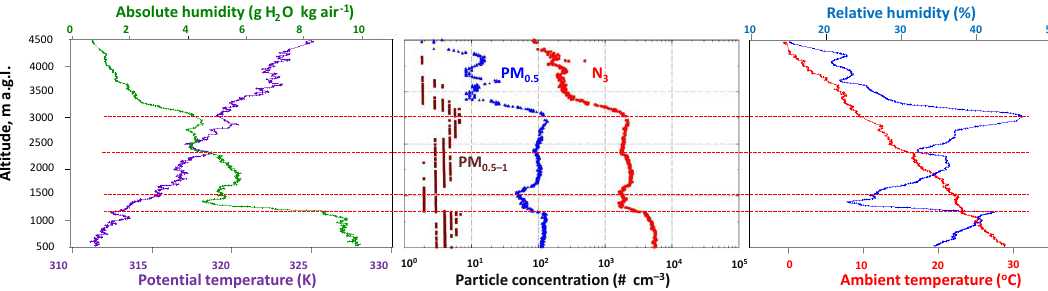
Figure 3. Data from the non-tethered balloon measurements (at VIC) of temperature, relative humidity and particle number concentrations performed from 10:00 to 11:30UTC on 16 July 2015. Red lines identify the limit between different atmospheric